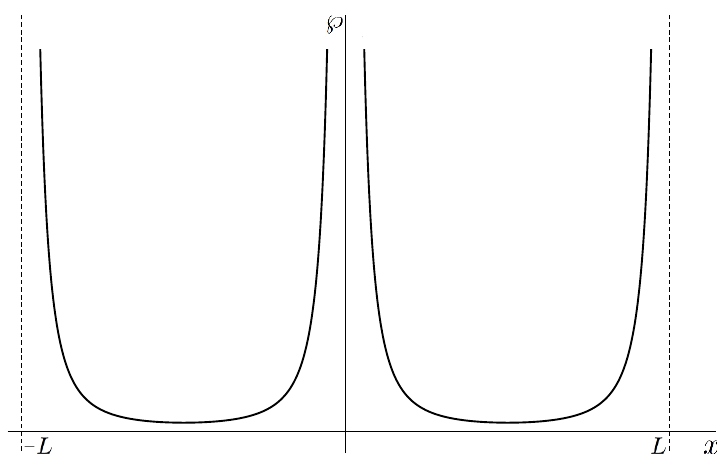
Figure 10. The Weierstrass } function with P 1 = L; P 2 = i(cid:12) , evaluated on the real